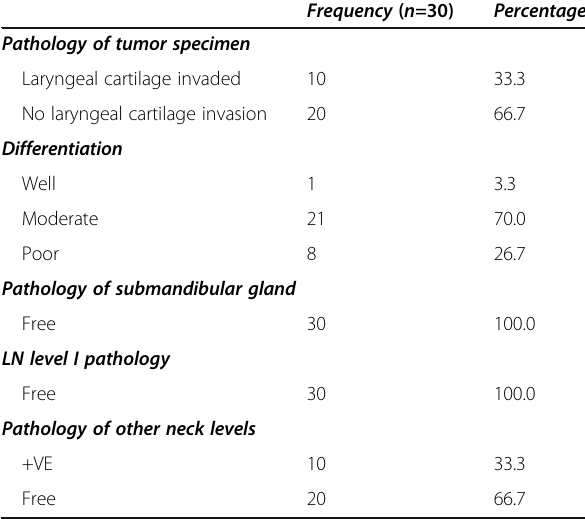
Table 2 Post-operative pathological exam of the specimen and pathology of dissected neck